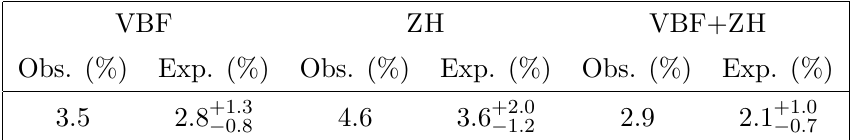
= 125 GeV on B (H → inv. + γ ) for the H